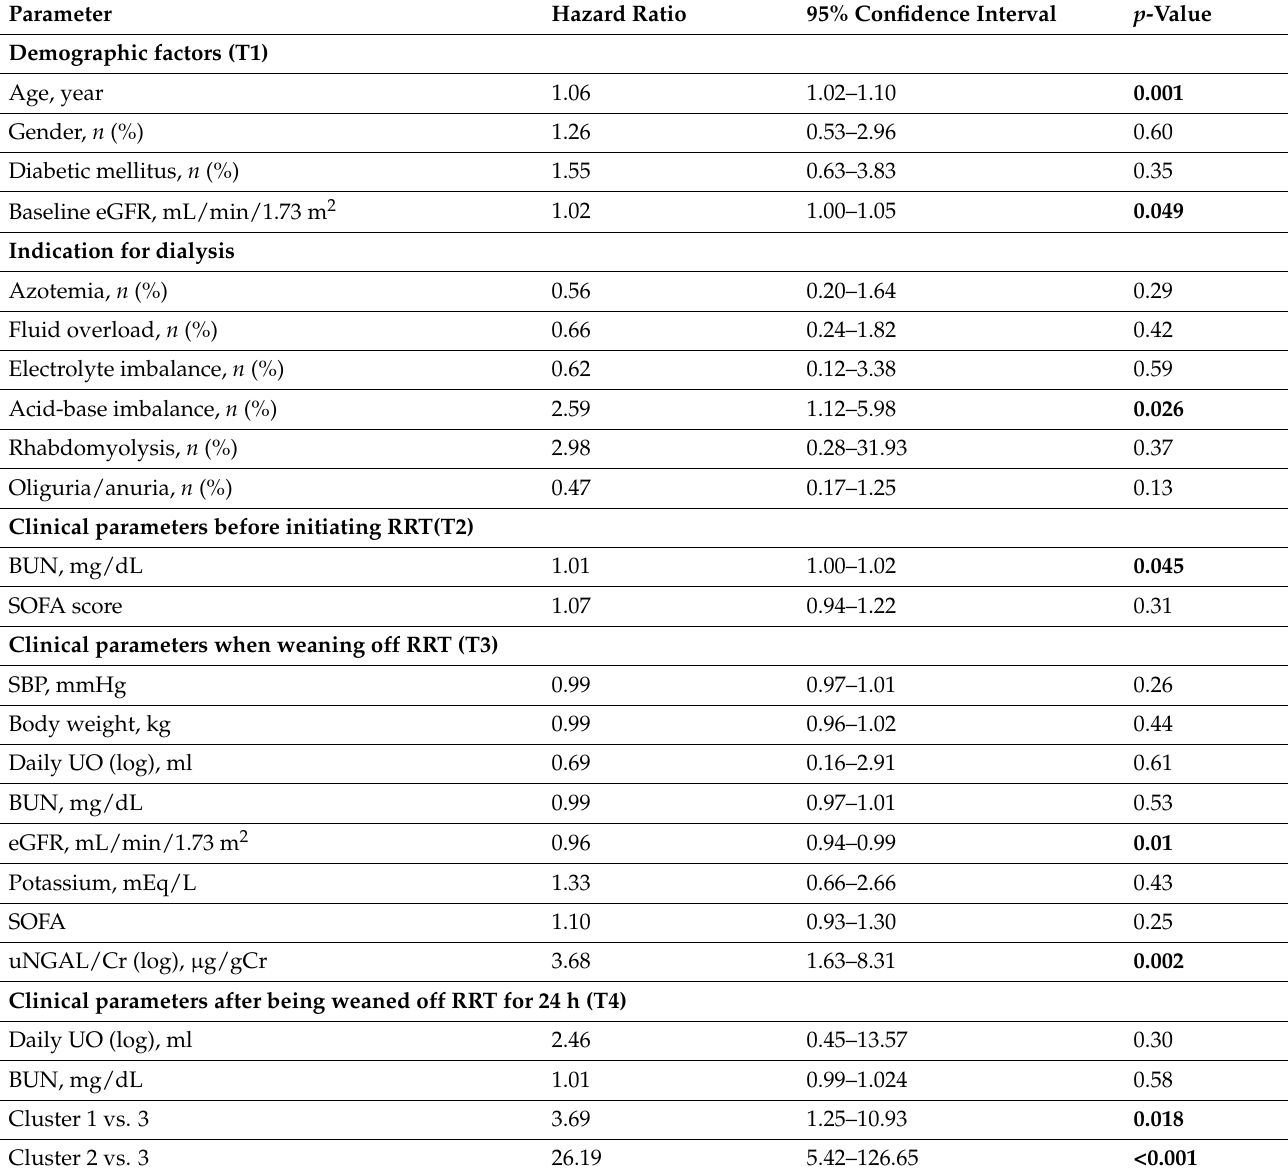
Table 2. Cox proportional hazards models depicting the 90-day mortality.